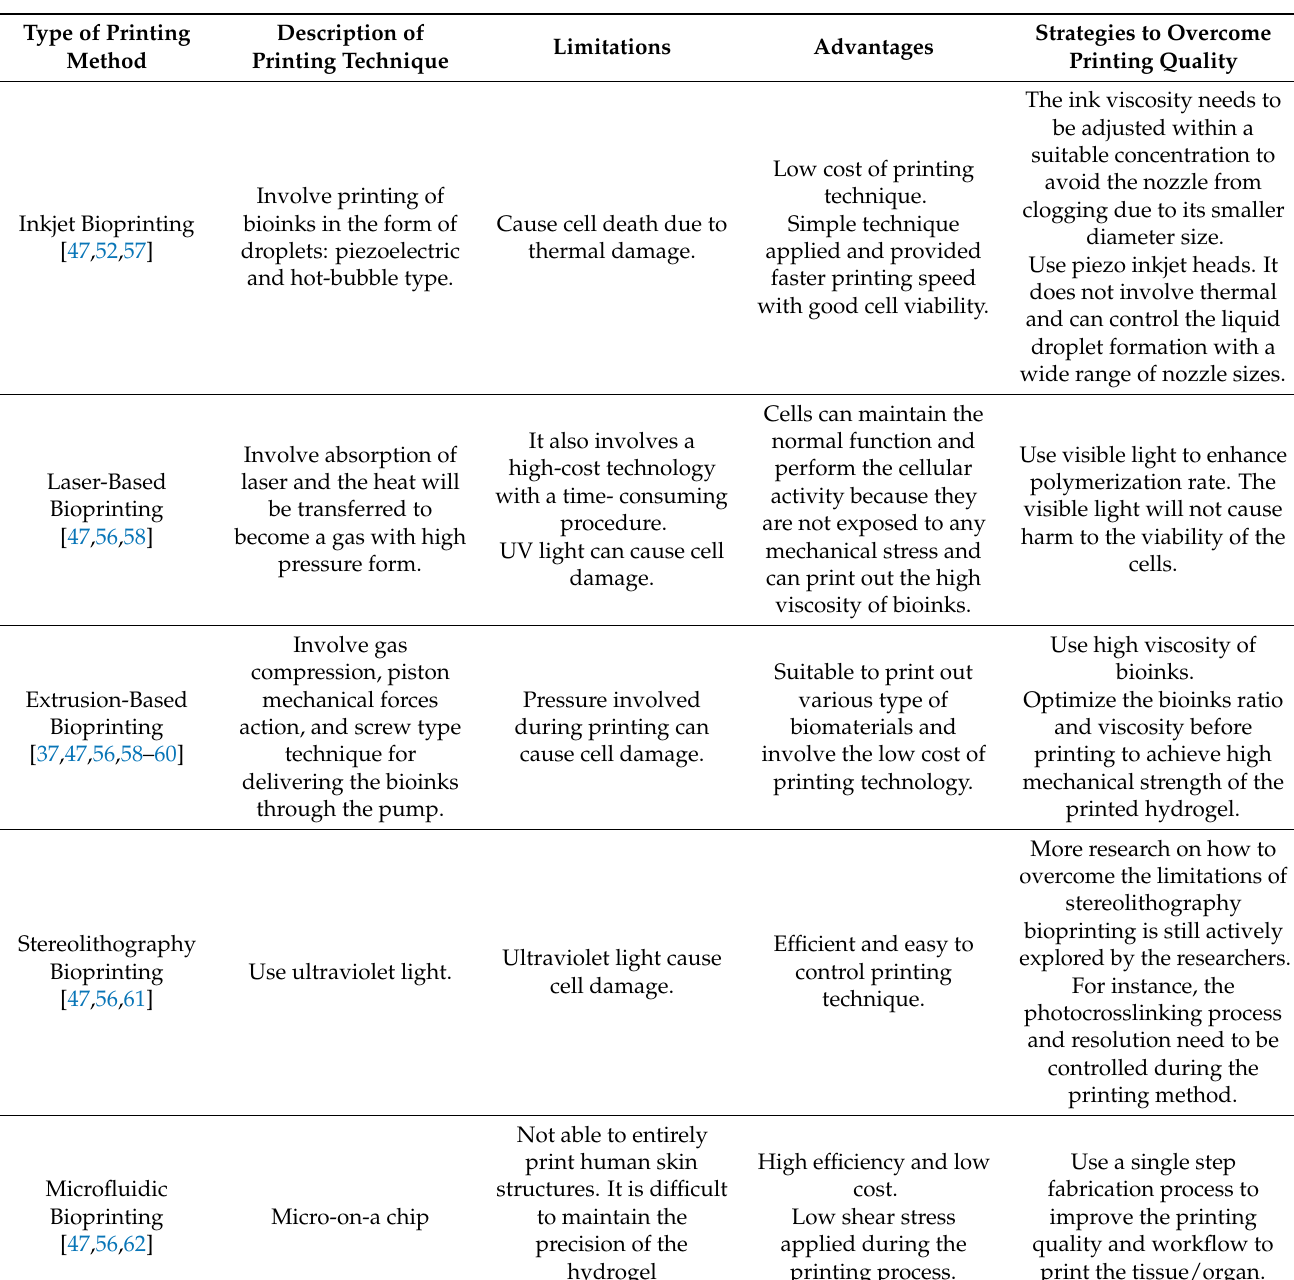
Table 4. The summary of limitations, advantages, and strategies to overcome printing quality of different types of bioprinting